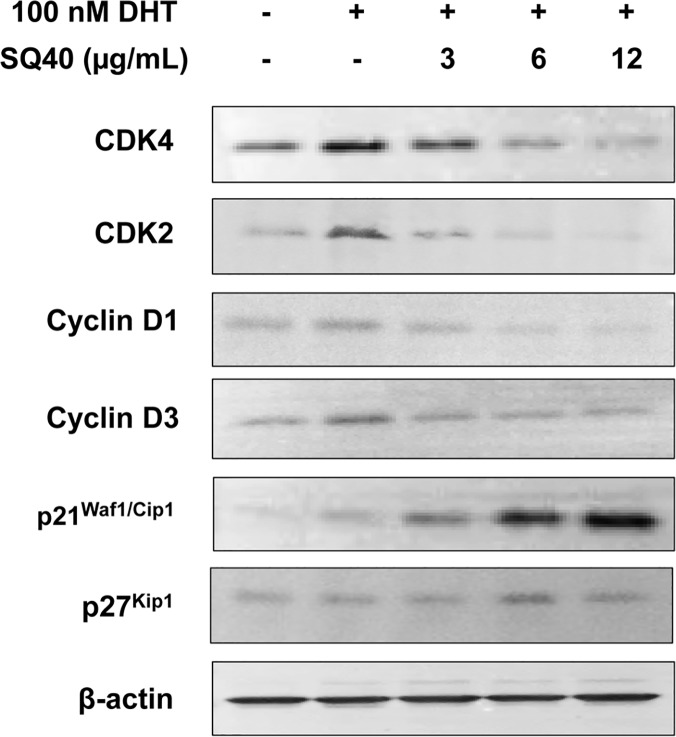
Protein expression of G1/S regulatory proteins in LNCaP cells treated with SQ40.LNCaP cells were first cultured in growth media supplemented with 5% CSS for 48 hours and then treated with 3, 6 and 12 μg/mL of SQ40 with the presence of 100 nM DHT for 72 hours. Immunoblotting was performed on protein extracts to detect CDK4, CDK2, Cyclin D1, Cyclin D3, p21Waf1/Cip1 and p27Kip1. β-actin served as a loading control.